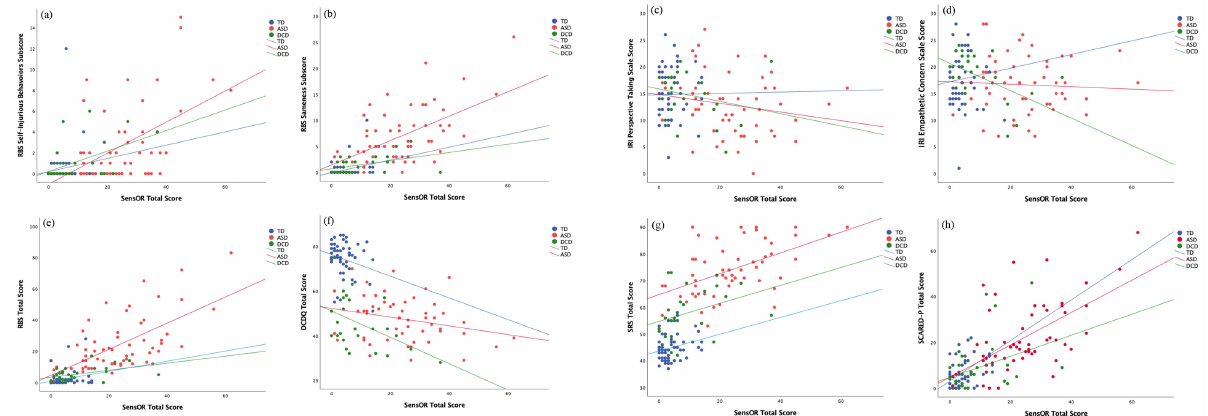
Figure 3. Scatterplots depicting significant correlations. ( a ) SensOR total and RBS-R self-injurious be- havior; ( b ) SensOR total and RBS-R sameness; ( c ) SensOR total and IRI perspective taking; ( d ) SensOR total and IRI empathetic concern; ( e ) SensOR total and RBS-R total score; ( f ) SensOR total and DCDQ total score; ( g ) SensOR total and SRS total score; ( h ) SensOR total and SCARED-P total